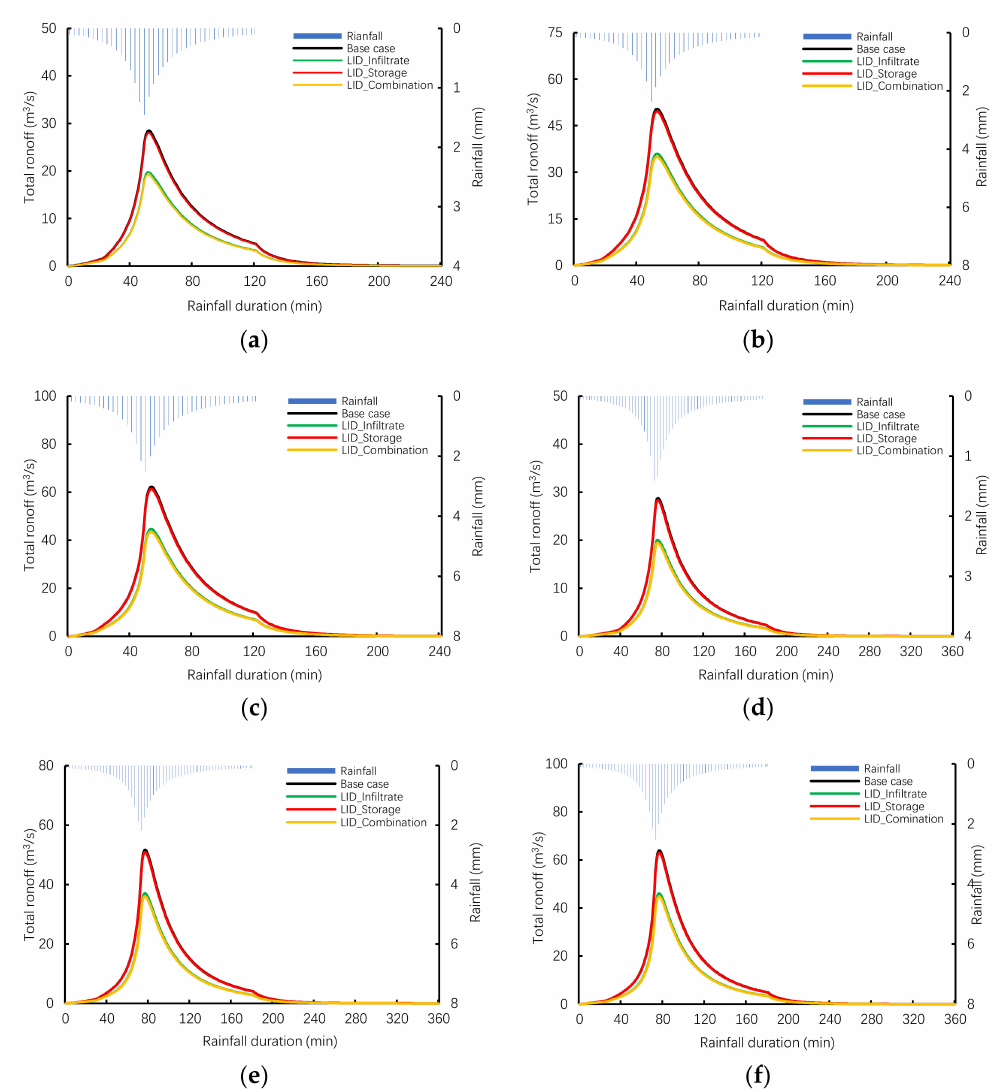
Figure 5. Rainfall–runoff relationship under different LID scenarios: ( a ) Rainfall duration is 120 min, return period is 1a; ( b ) Rainfall duration is 120 min, return period is 3a; ( c ) Rainfall duration is 120 min, return period is 5a; ( d ) Rainfall duration is 180 min, return period is 1a; ( e ) Rainfall duration is 180